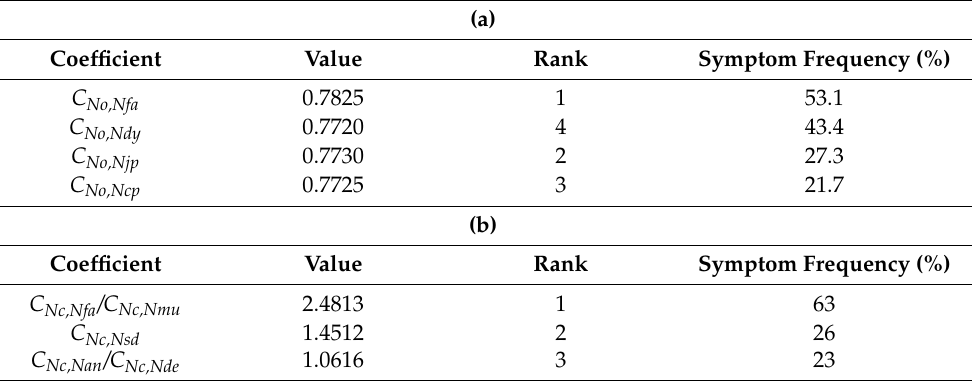
Table 3. ( a ). Path module correlation coefficient between the European SCRGs module and the corresponding LCSIGs module. The rank of the path module correlation coefficient calculated by us is basically consistent with the rank of the long-COVID symptoms frequency described in the paper [24], except for the symptom of dyspnea. ( b ). Path module association coefficient between the Chinese SCRGs module and the corresponding LCSIGs module. The path module correlation coefficients of combined fatigue and muscle weakness symptoms genes and the COVID-19 genes and combined anxiety and depression symptoms genes and the COVID-19 genes were determined. The rank of the path module correlation coefficients is completely consistent with the rank of the long-COVID symptoms’ frequency described in the paper [24]. (a) Coefficient Value Symptom Frequency (%)